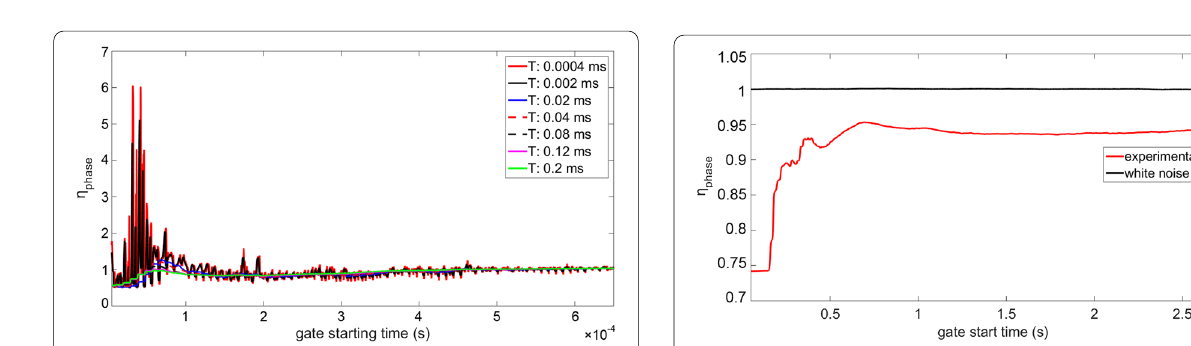
Figure 10 Diffuse field verification on experimental data with different window size using metric η phase